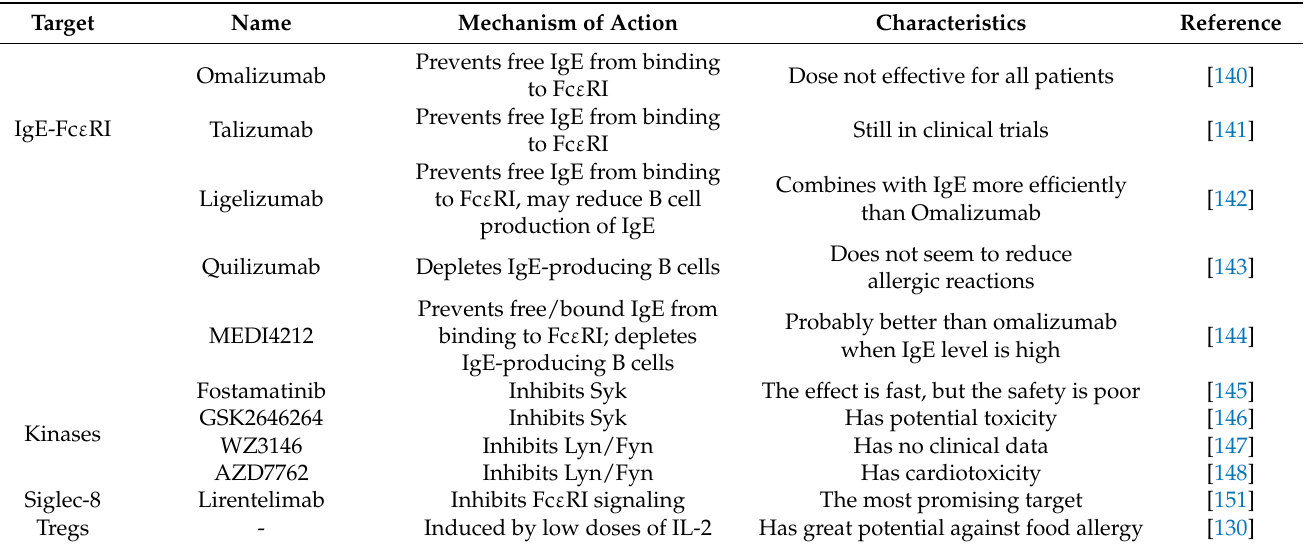
Table 1. Novel prospective MCs-targeting